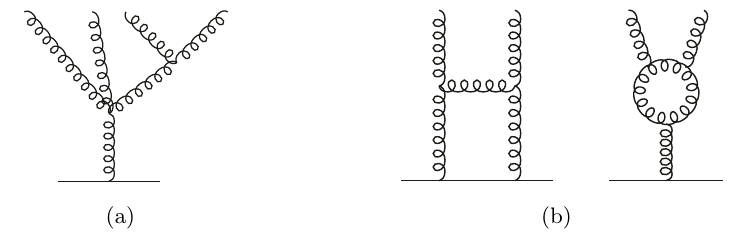
Figure 6 . Example graphs for n m gluon transitions of order g n (cid:0) m (a) and of higher order (b). ! of order g n (cid:0) m are only realised by tree graphs with sequential transitions from 2 from 3 1 gluons, as shown in (cid:12)gure 6(a). Any further interactions, as in (cid:12)gure !